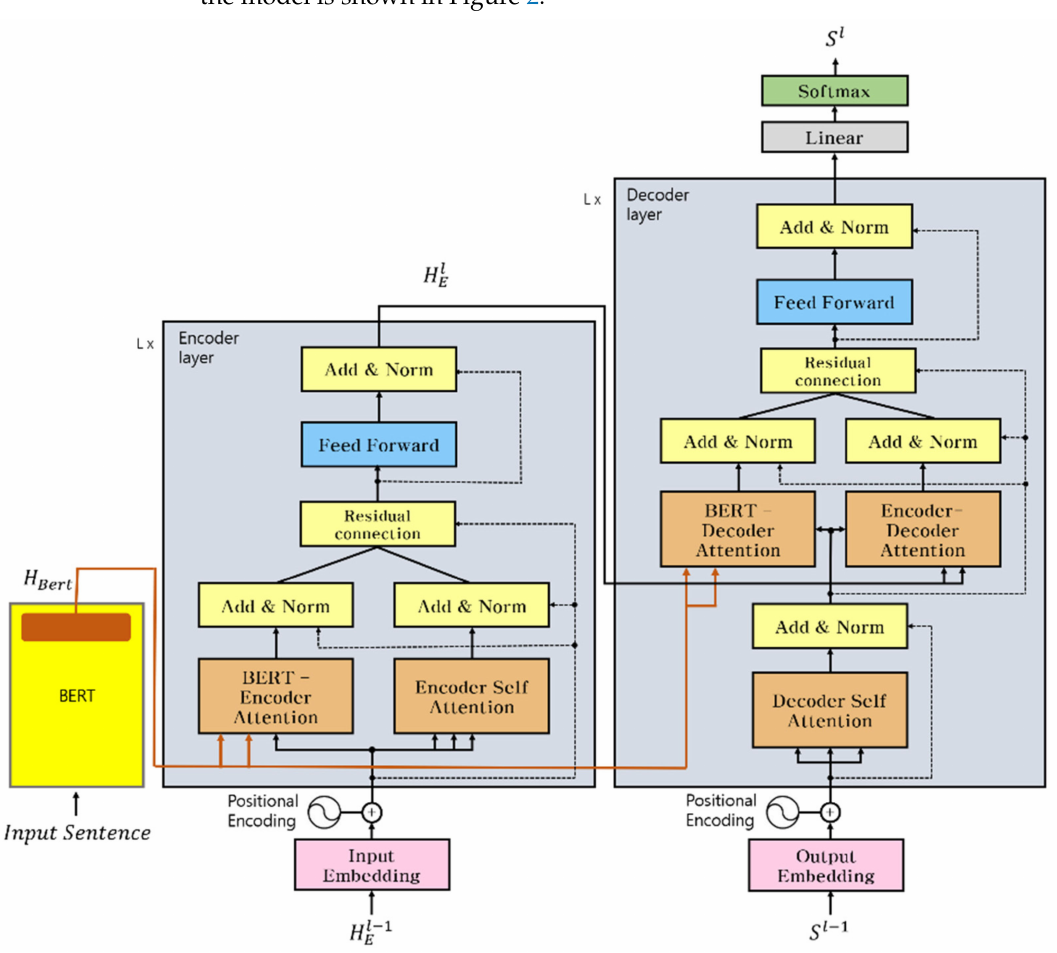
Figure 2. Incorporating a context encoder into the Transformer model by applying the cardinality residual